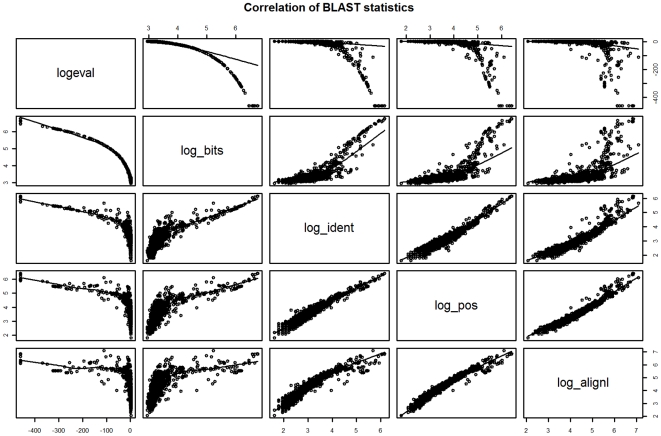
Correlation between log-transformed BLAST statistics.BLAST statistics are generally highly correlated with each other. If two variables are highly correlated the information they provide about a response variable (i.e. RIC) is not independent. Generally only one of the variables in this case will add significant predictive power to a statistical model.